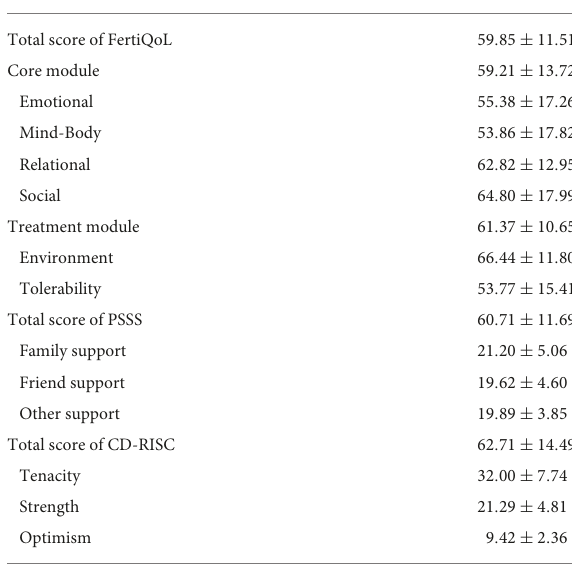
TABLE 2 Fertility-related quality of life (FertiQoL), perceived social support scale (PSSS), and Connor-Davidson Resilience Scale (CD-RISC)